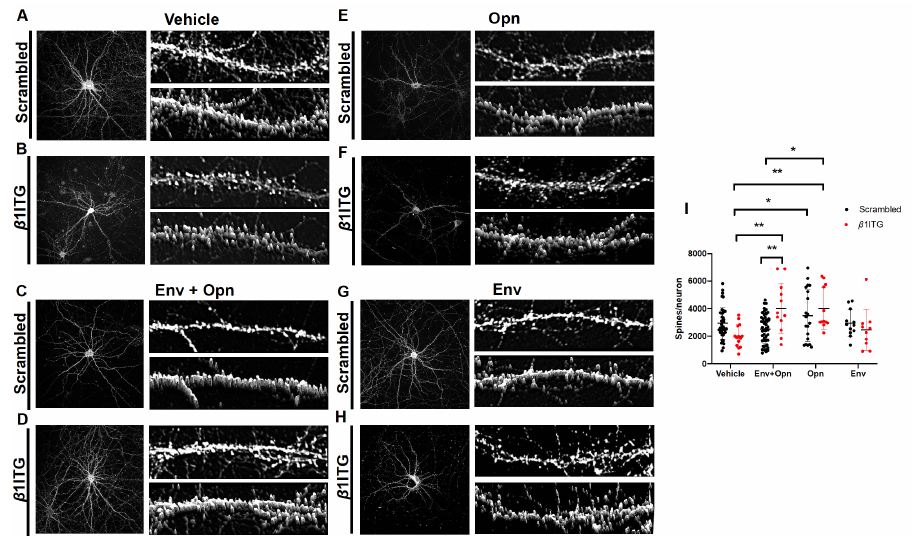
Figure 2. β 1 integrin modulates spine density in the presence of HIV-1 Env and Opn.